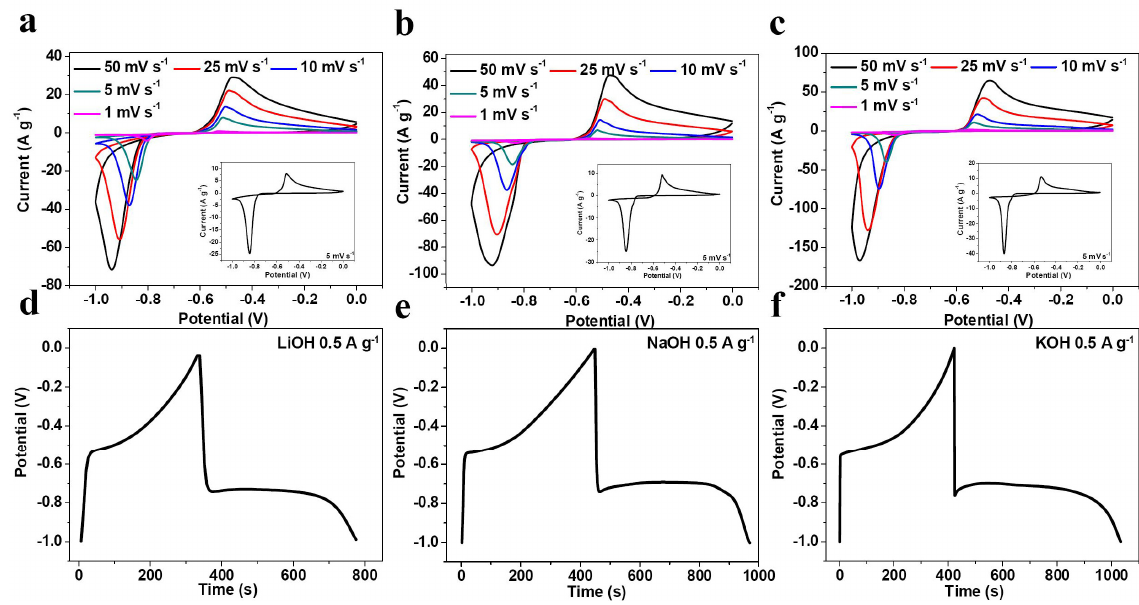
Figure 2. Cyclic voltammograms (CV) curves at different scan rates and in different electrolytes: ( a ) 1 M LiOH; ( b ) 1 M NaOH; ( c ) 1 M KOH. Galvanostatic charge-discharge curves at 0.5 A·g − 1 in ( d ) 1 M LiOH; ( e ) 1 M NaOH and ( f ) 1M KOH